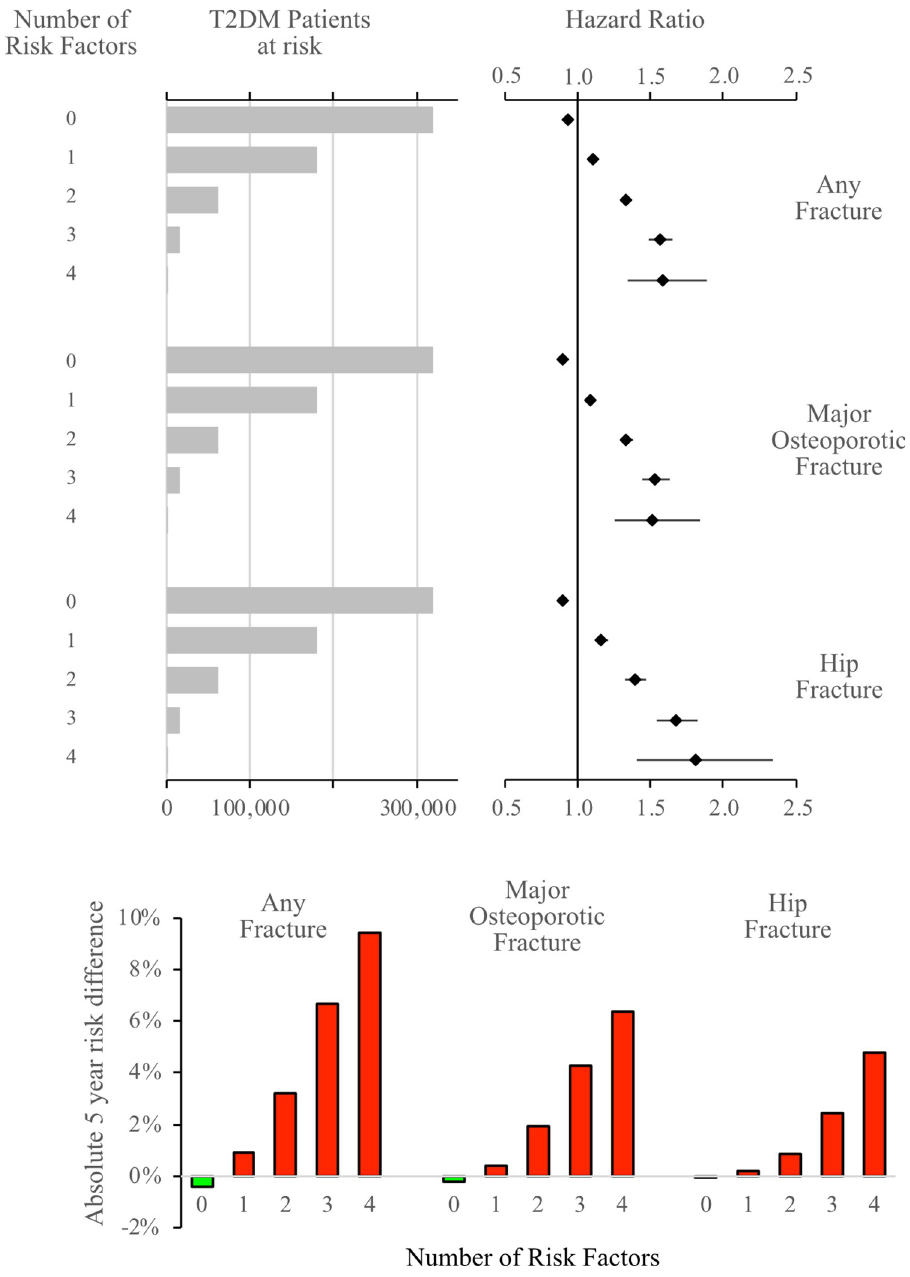
Fig 3. Relative and absolute risk of fracture in T2DM patients—per number of risk factors compared to matched controls. Relative and absolute risk difference in T2DM patients per number of risk factors compared to matched controls using a multivariable-adjusted Cox regression model. The 4 diabetes-related risk factors were: (1) BMI < 25; (2) time since diabetes diagnosis > 15 years; (3) insulin treatment; and (4) absence of physical activity. T2DM, type 2 diabetes